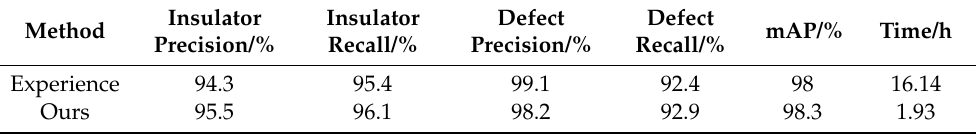
Table 7. Comparison of results from different valuation